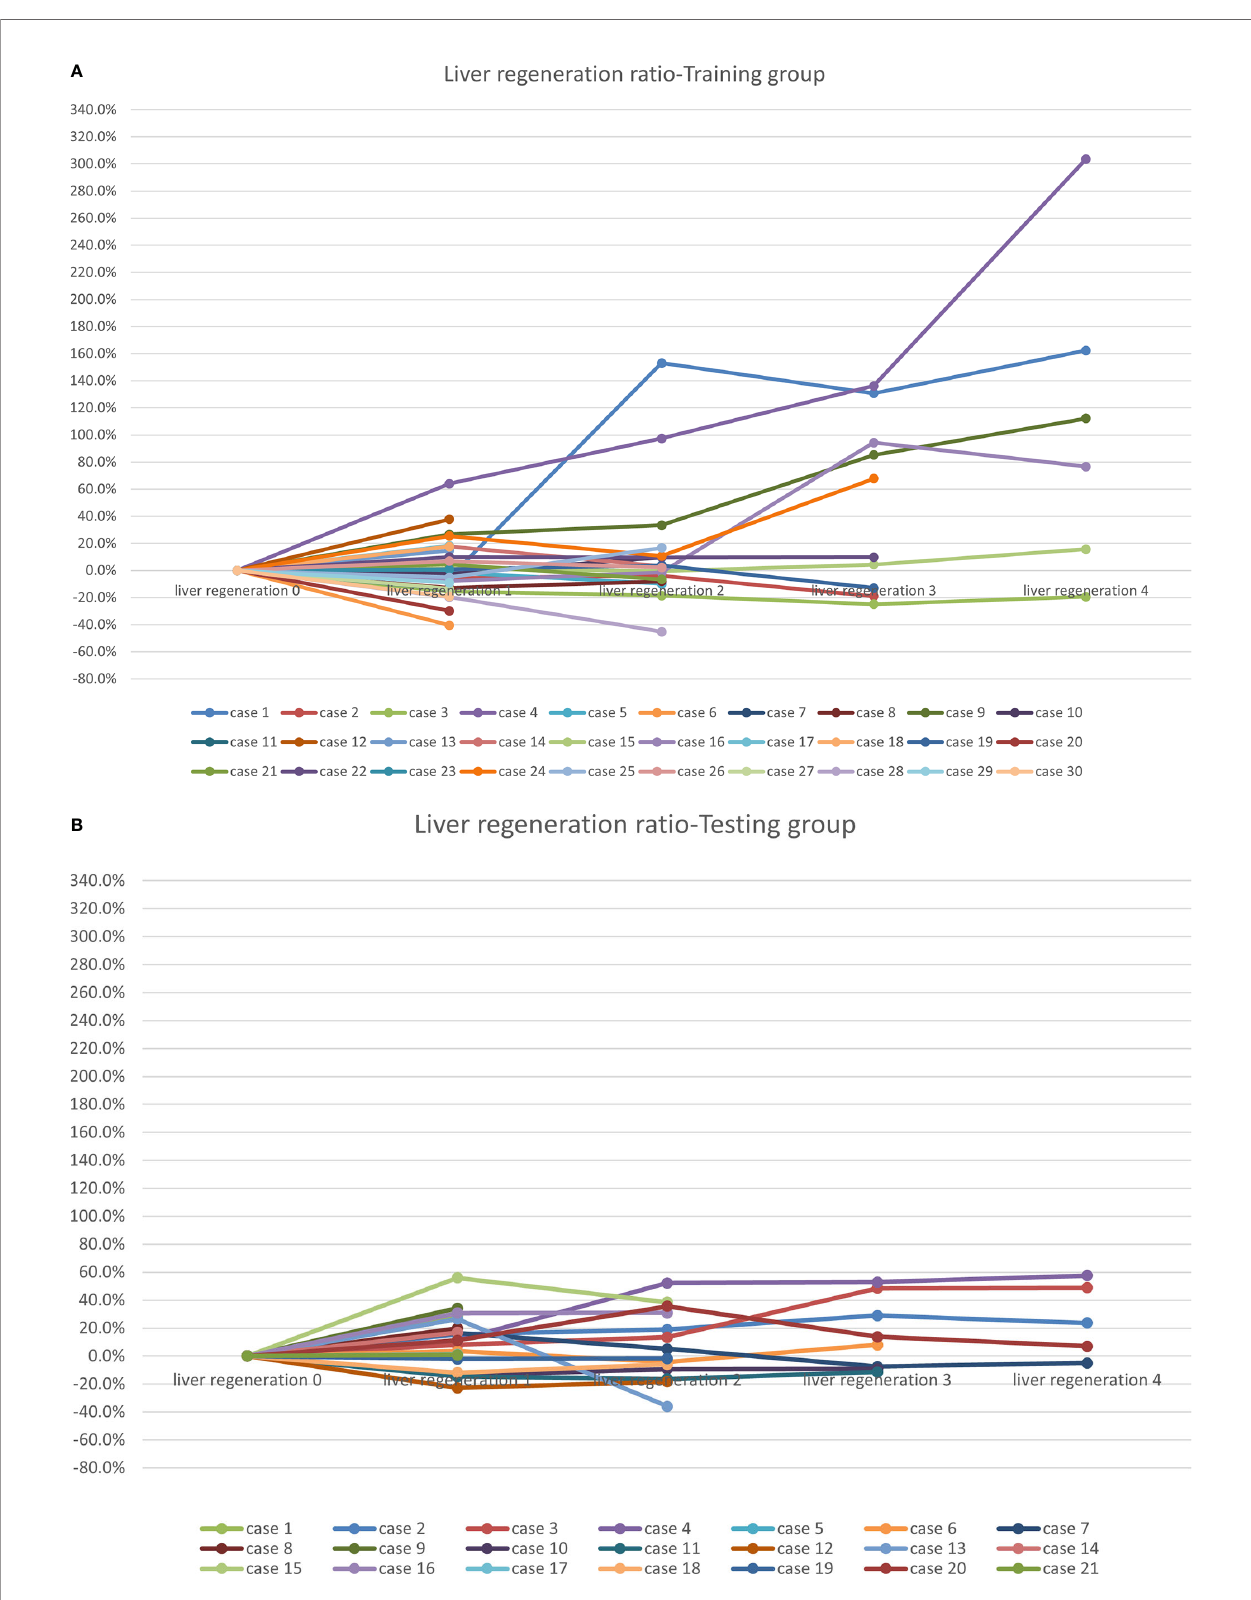
FIGURE 2 | Liver regeneration growth ratio after radiotherapy: (A) the training cohort; and (B) the testing